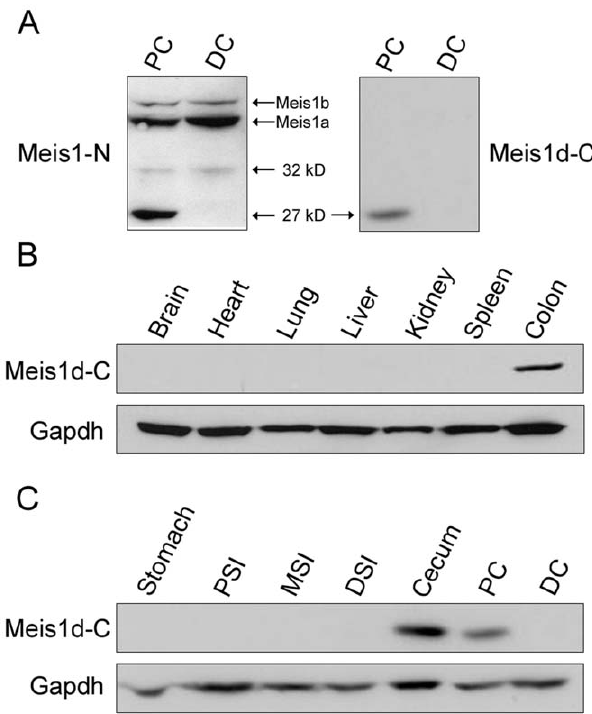
Figure 2. The Meis1d protein is present in the murine colon. A) Western blot analysis of B6 proximal and distal colon lysates with the Meis1-N and Meis1d-C antibodies. The positions of Meis1, Meis1b, and the two novel Meis1 products are labeled. B) and C) Lysates from a panel of B6 organs were probed with the Meis1d-C antibody. Gapdh was used as a loading control.